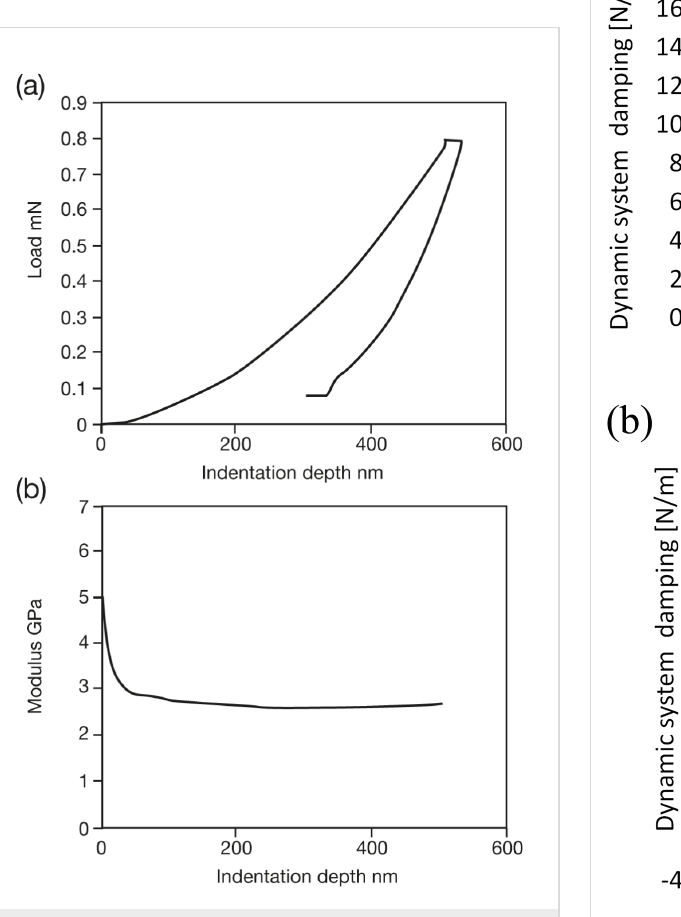
Figure 5: Modulus measurements on polypropylene (A) Load-vs- deformation curve (B) Reduced storage modulus determined using continuous stiffness measurement vs depth. CSM modulation ampli- tude 5 nm at 45 Hz.